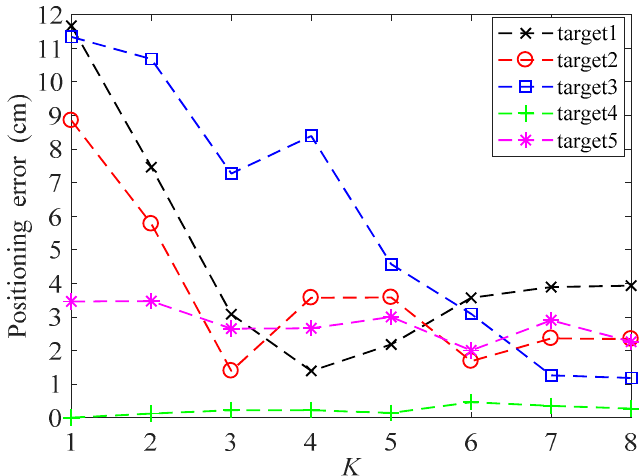
Figure 4. Positioning errors of 5 targets using weighted K -nearest neighbor (WKNN) algorithm.